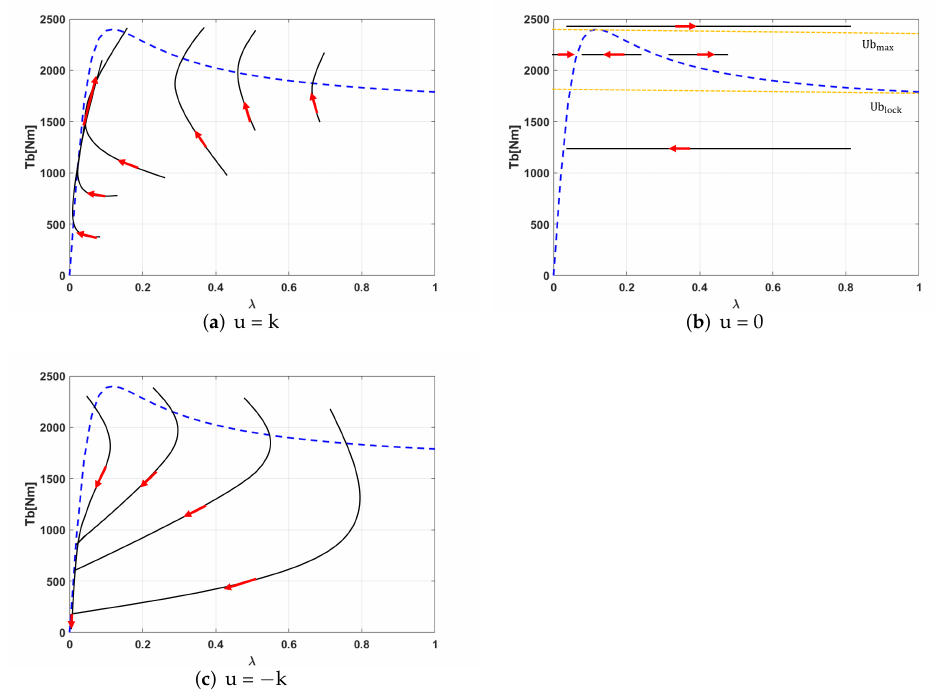
Figure 5. System trajectories of states λ and T b when K = r ( a ), K = 0 ( b ), and K = − r ( c ).